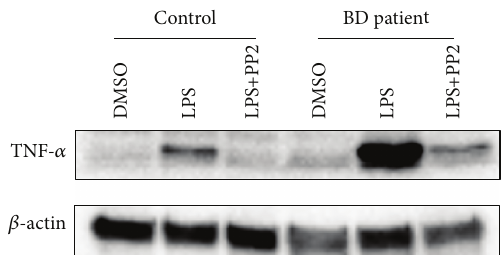
Figure 3: Inhibition of LPS-induced TNF- 𝛼 production by PP2 in PBMC of active BD patients. Five × 10 6 PBMC were treated with 10 𝜇 M PP2 for 1h before 100ng/mL LPS stimulation for 18 h. Cell lysates were examined for the presence of TNF- 𝛼 by Western Blotting. The lowest panel represents loading control ( 𝛽 -actin). The image shown represents a single representative example of four separate